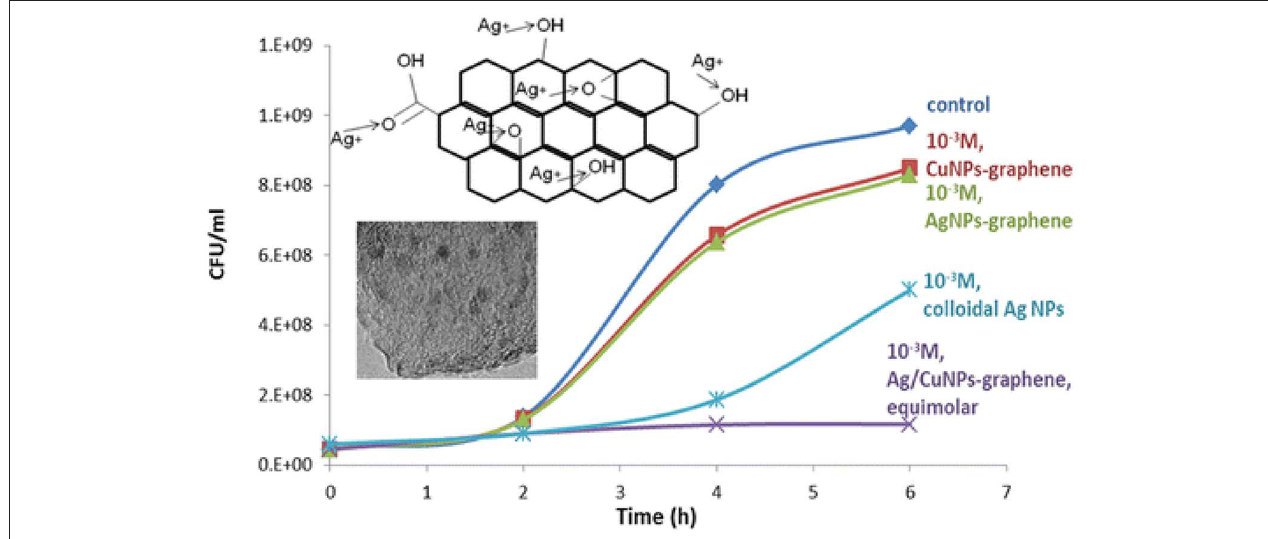
FIGURE 5 | Enhanced antibacterial action of Ag/Cu bimetallic graphene hybrids. Reproduced from Perdikaki et al. (2016) with permission from the American Chemical Society.